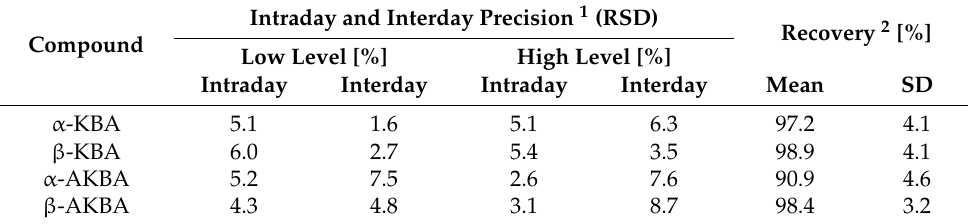
Table A2. HPLC-MS/MS validation data: Precision and